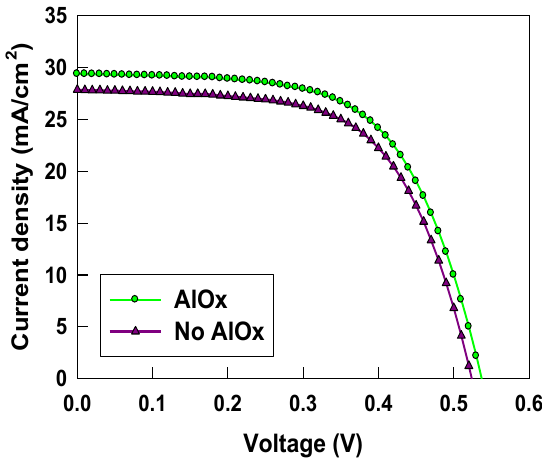
and with AlO samples. x x